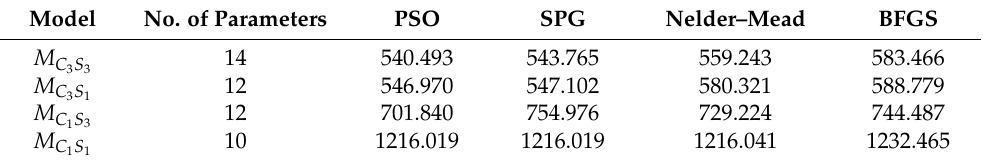
Table 2. Akaike Information Criterion (AIC) for alternative population reconstruction models of North American river otter in Indiana, USA, 2015–2020, using four different numerical optimization methods (particle swarm optimization (PSO), spectral projected gradient (SPG), Nelder–Mead, and Broyden–Fletcher–Goldfarb–Shanno (BFGS)). Models assumed harvest vulnerability ( C ) and natural survival ( S ) were either the same for all age-classes (subscript 1) or differed for young-of-the-year, yearlings, and adults (subscript